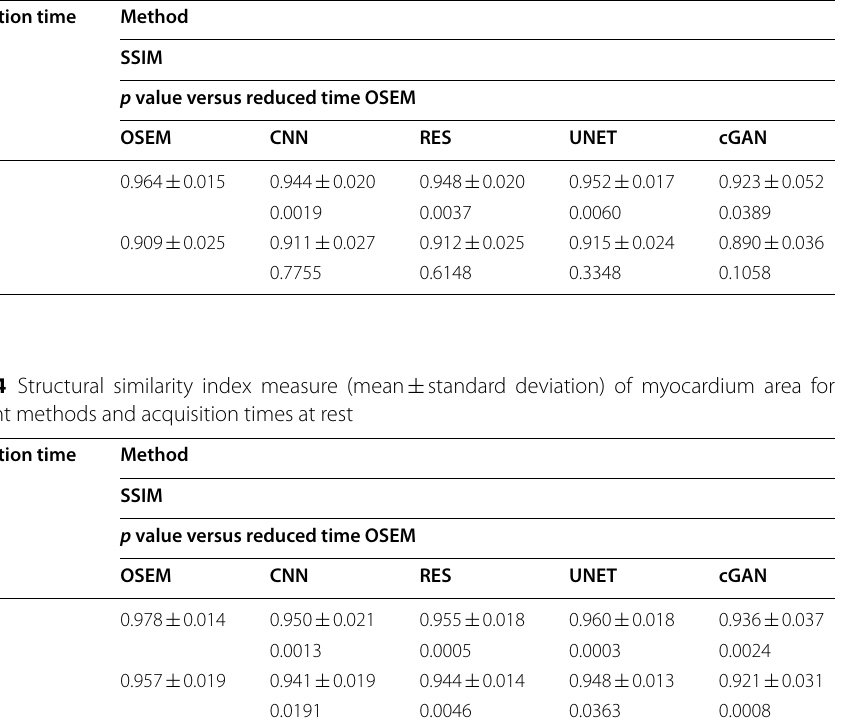
standard deviation) of myocardium area for ±